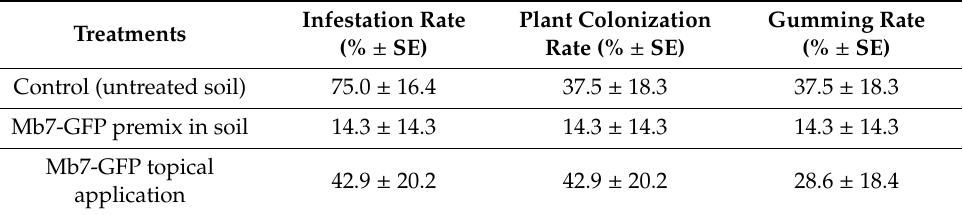
Table 4. Trial 2018: infestation, colonization, and gumming rates of C. tenebrionis larvae on potted rootstocks treated with Mb7-GFP premix, topsoil application, or untreated soil (control).